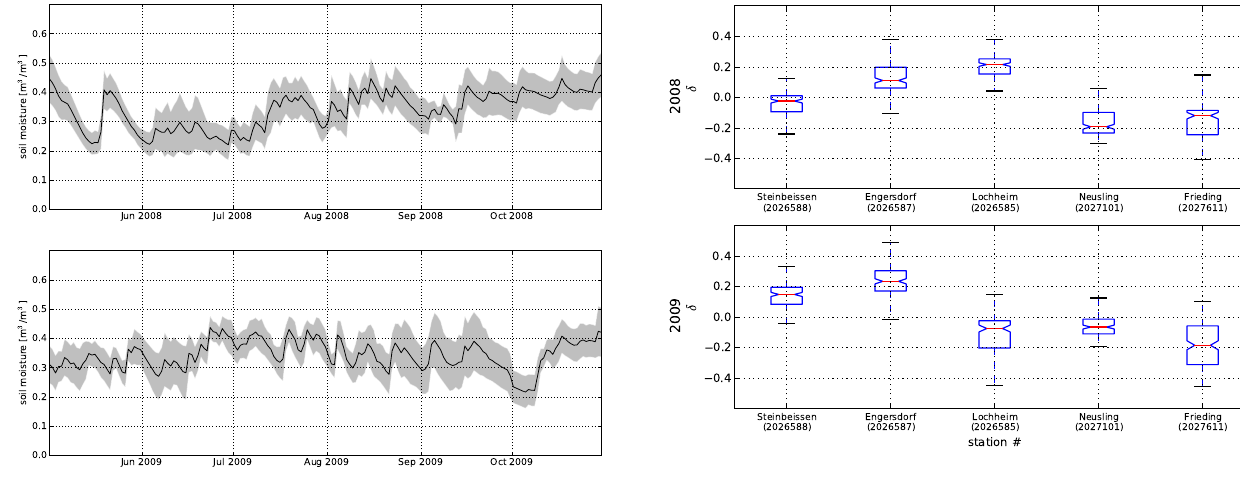
Fig. 3. Boxplot of the relative difference ¯ δ between soil moisture observations of a single station and the spatial mean ¯ θ . Boundaries of the boxes correspond to the 25% and 75% quartiles and the line indicates the median value. Whiskers indicate extreme values. Table 1. List of soil moisture stations, IDs of closest ISEA grid point and assigned experiment